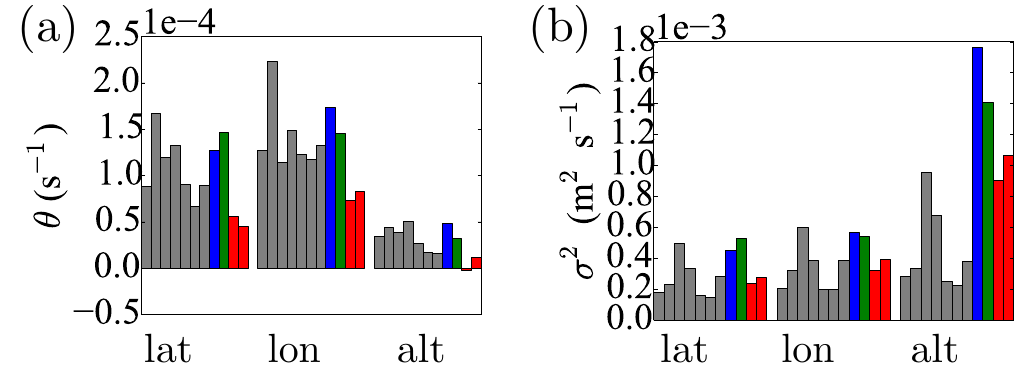
Figure 4. Fitted Ornstein–Uhlenbeck (OU) parameters to GPS time-series from Dunedin, New Zealand (grey), North Stradbroke Island, Australia (blue), Port Douglas, Australia (green), and Thursday Island, Australia (red). ( a ) Estimates of θ show no significant variation over geographic locations; however, the difference between the types of coordinates is apparent, θ being much smaller for altitude (alt) than for either latitude (lat) or longitude (lon). ( b ) Estimates of parameter σ 2 are depicted and show a similar pattern to θ in ( a ), although, here, the altitude is much larger than the other two coordinates. Qualitatively, this can be understood by the larger variability of the altitude residuals (see Figure